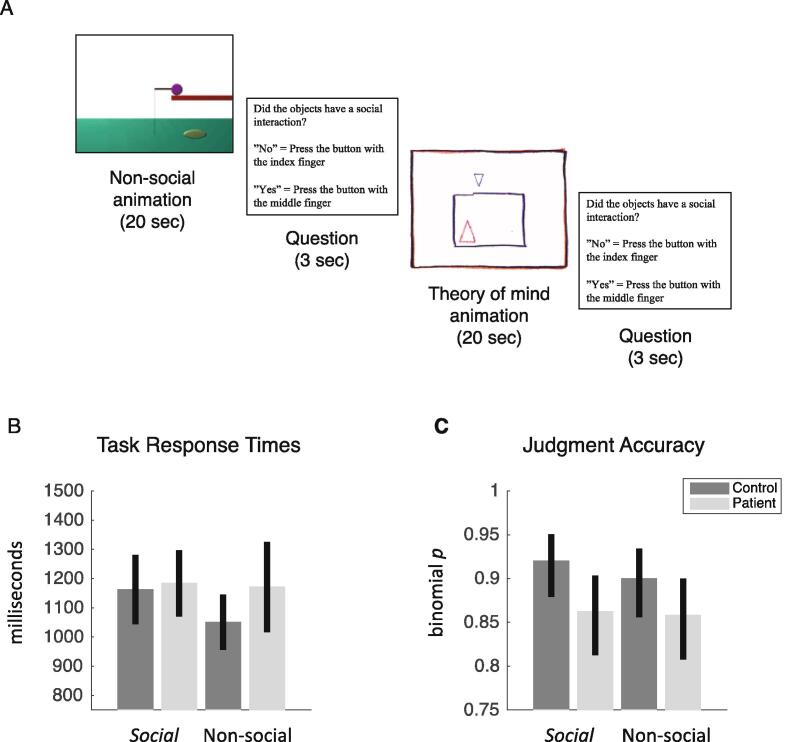
Judgment of social versus non-social stimuli (A) Social cognition paradigm (B) Response times with 95% confidence intervals (C) Judgment accuracy with 95% confidence intervals: patients with schizophrenia were less accurate in detecting social scenarios than healthy controls, with no consistent difference between groups when judging non-social scenarios.